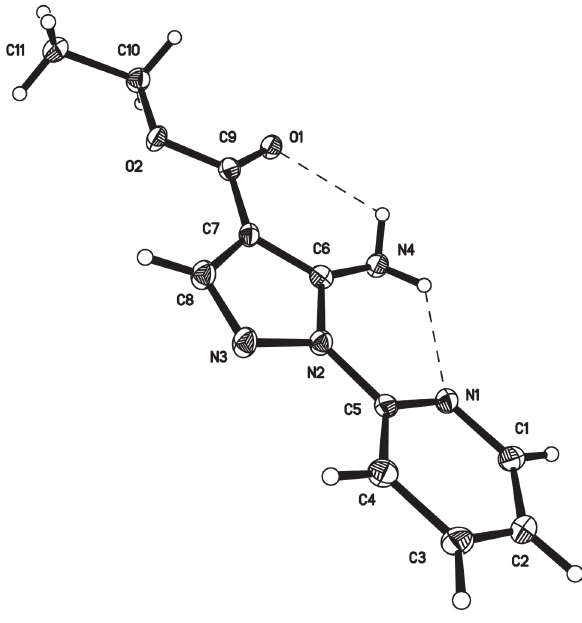
Table 1: Data collection and